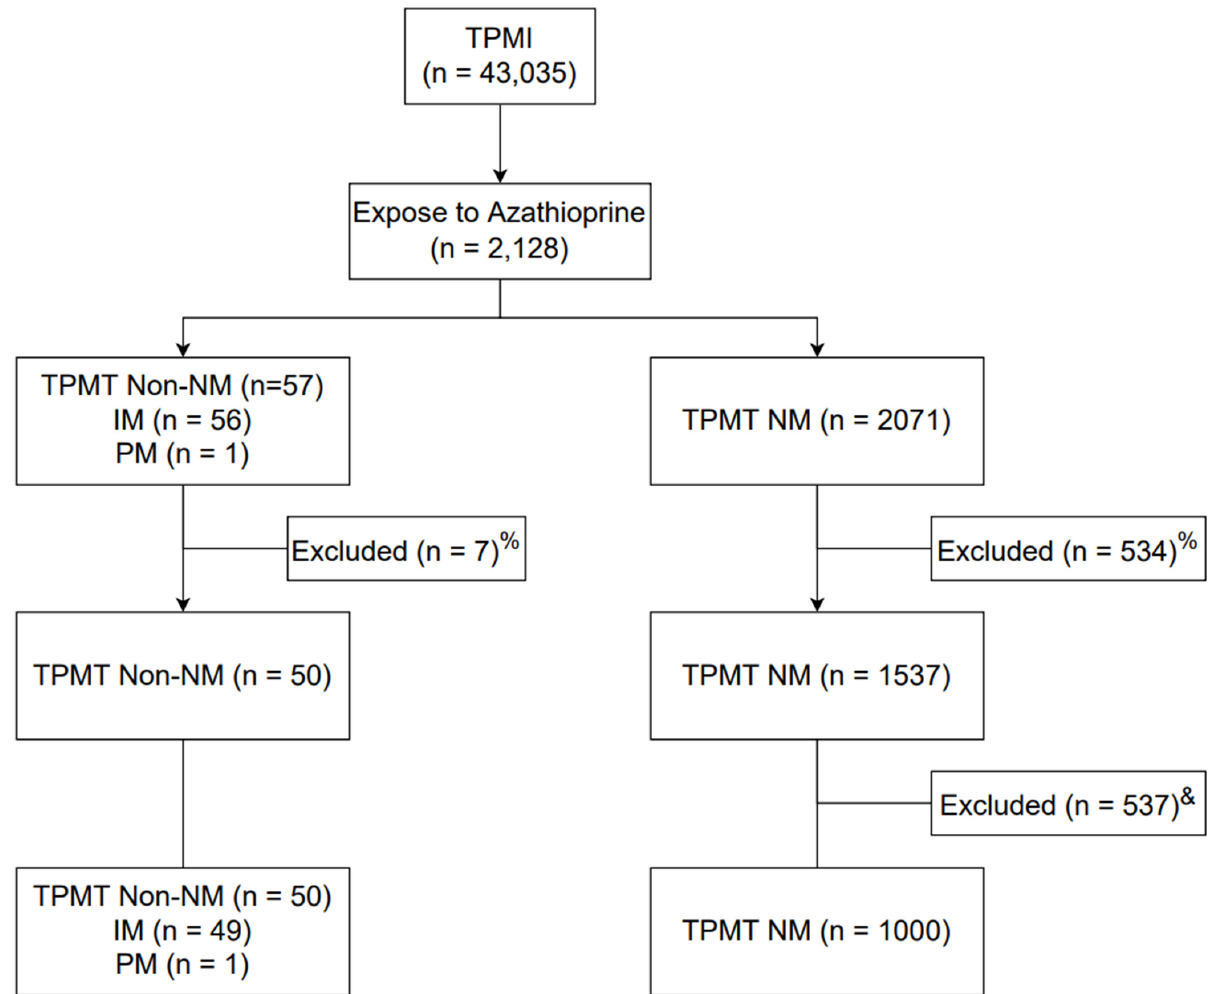
Figure 1. Patient enrollment flowchart. % 1. Exclude patients without WBC count and ALT data; 2.